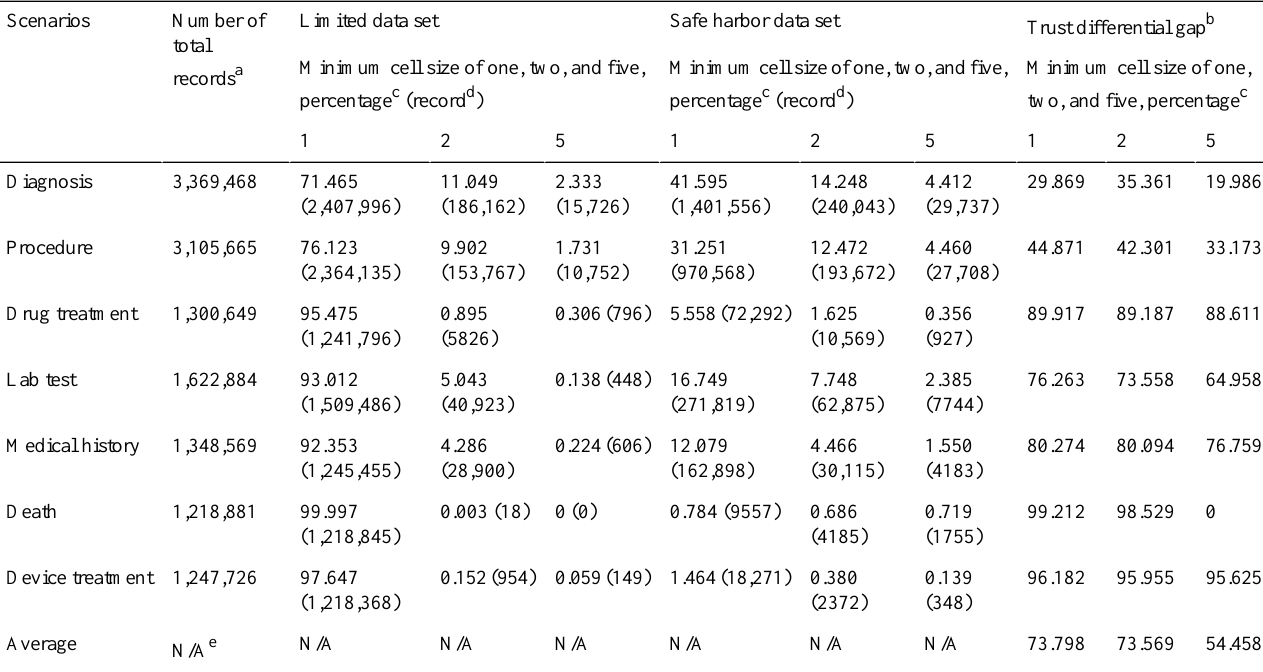
Table 5. Percentage of records measuring quasi-identifier privacy risk with gaps between the limited and safe harbor data sets with a minimum cell size of one, two, and